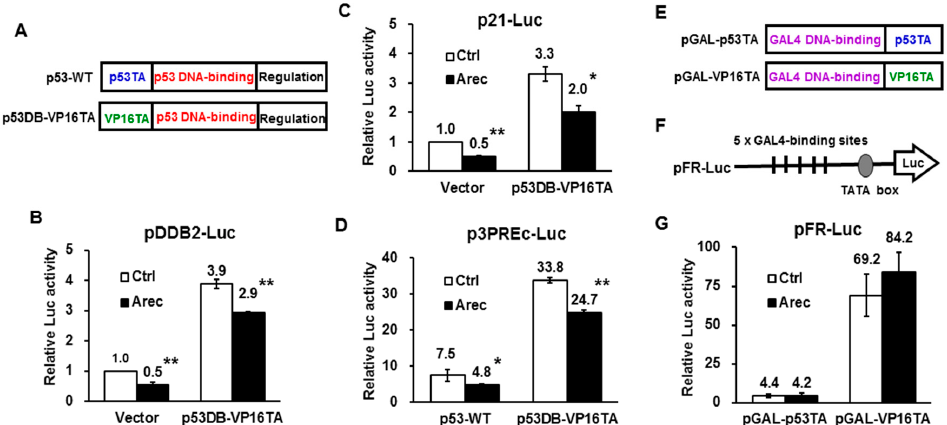
Figure 4. Arecoline inhibits p53-regulated promoters through p53’s DNA-binding domain in